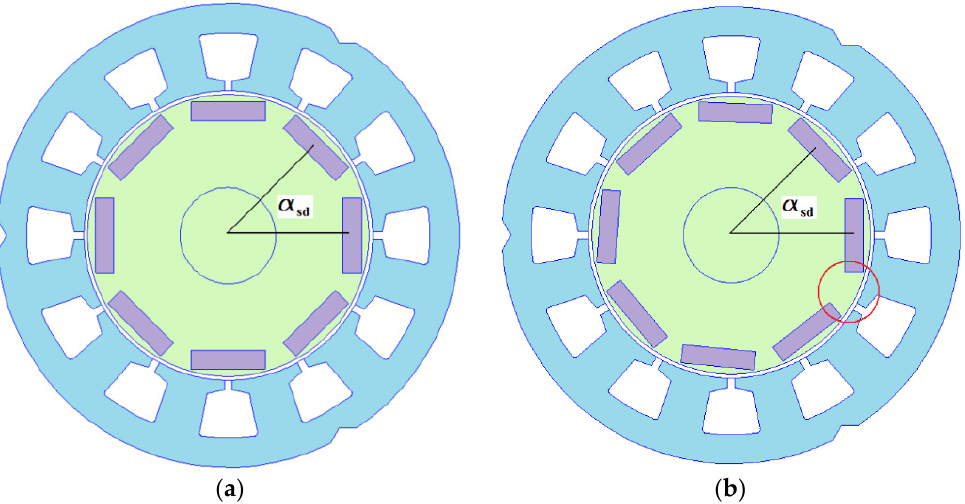
Figure 6. Example of the symmetric ( a ) and asymmetric ( b ) machines.